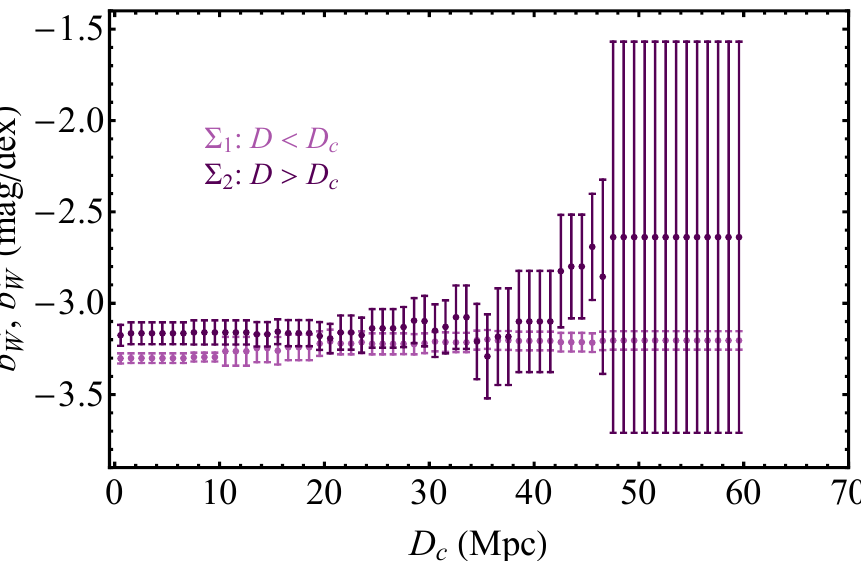
Figure 3. Binned Cepheid P-L slopes b > distance bin Σ 1 ( D < D c ), respectively. In each bin, σ scat was used and adjusted so that χ 2 Notice that for D c (cid:39) 50 Mpc, the high–low-distance bins are statistically consistent with each other due to small number of Cepheids in the high-distance bin, but the difference of their slope best-fit values is